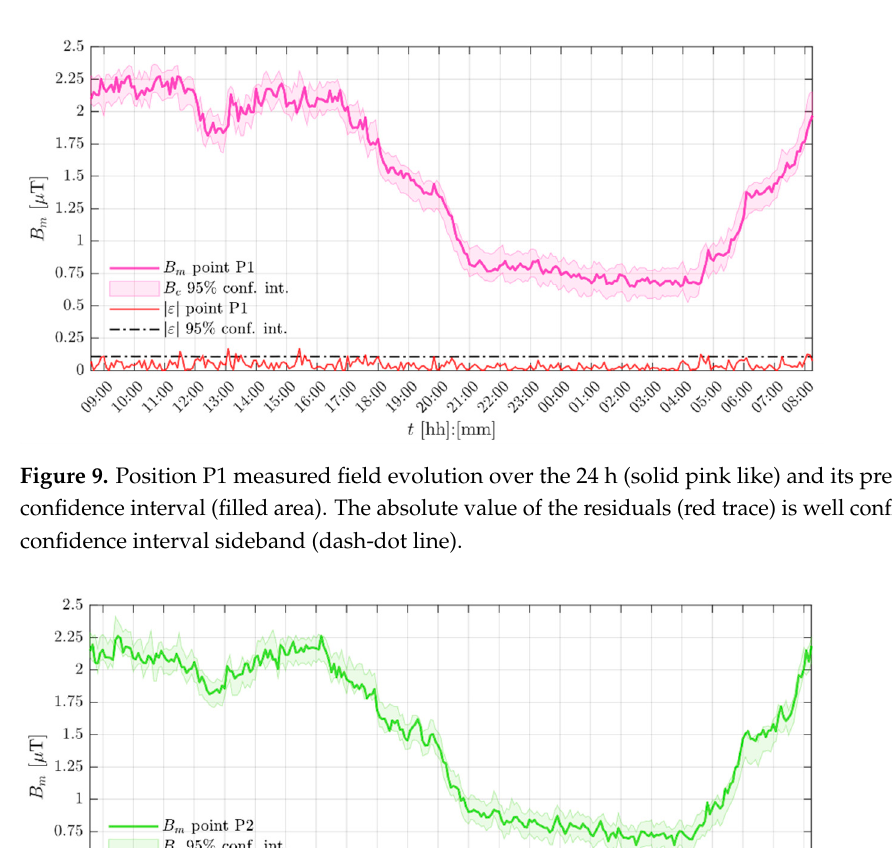
Figure 8. Proposed technique performance assessment for points P1 ( left ) and P2 ( right ).